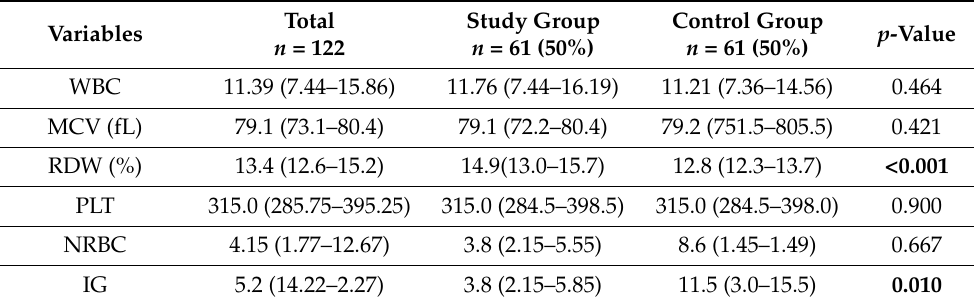
Table 5. The complete blood count results of children study and control